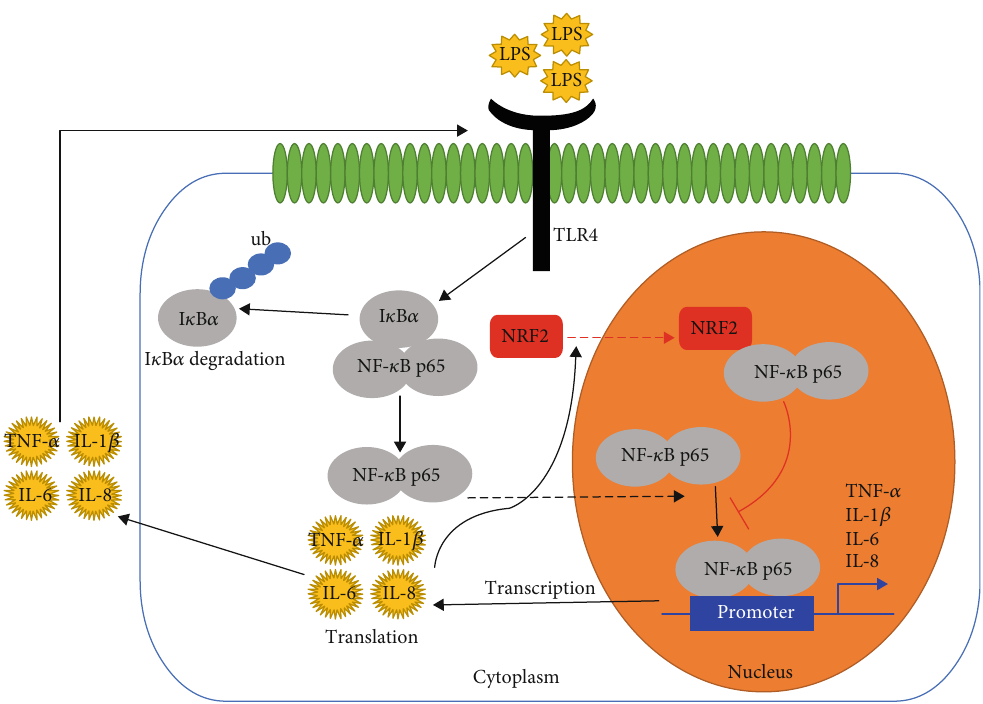
Figure 8: NRF2 exerts anti-in fl ammatory e ff ects in LPS-induced gEECs via TLR4/NF- κ B pathway. Graphic description of this study. Proin fl ammatory cytokines induced by LPS through the TLR4/NF- κ B pathway promoted NRF2 expression and transferred into the nucleus, and the nucleus NRF2 inhibited the expression of proin fl ammatory cytokines by directly binding to